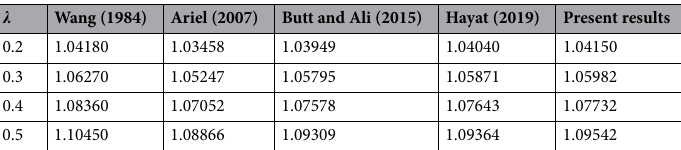
f ′′ ( 0 ) for different values of stretching ratio (cid:31) when γ =0.0 = φ . Table 5. Comparison of −